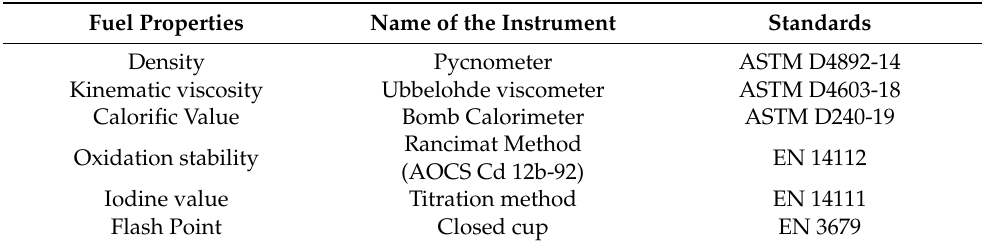
Table 3. List of the instruments